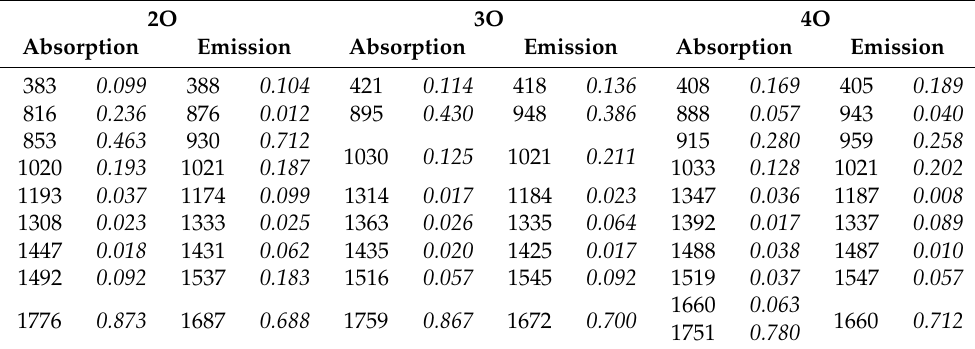
Table 5. The frequencies [in cm − 1 ] and HR factors (italicized) calculated at the CC2/def2-TZVPP level of theory for three lowest members of the oligofuran series. The normal modes that contribute less than 1% to the total reorganization energy are omitted for clarity. 2O 3O 4O Absorption Emission Absorption Emission